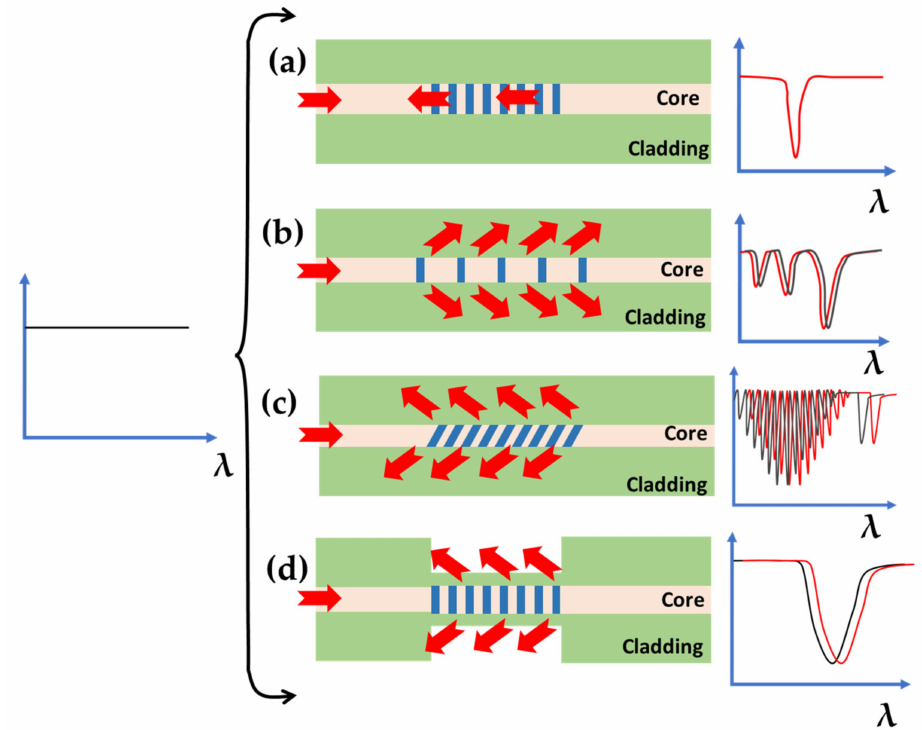
Figure 9. Basic configurations of fiber gratings. ( a ) Standard FBG which cannot be used as refractive index (RI) sensor. ( b ) Standard LPFG without any coating. ( c ) Tilted FBG. ( d ) Etched FBG. The arrows show the interaction of light coupled into the fiber with the outside medium. The plot on the right shows the transmission spectrum in the presence of a broadband source shown on the left. The red curves in these plots are the transmission spectra due to the increase in RI of outside